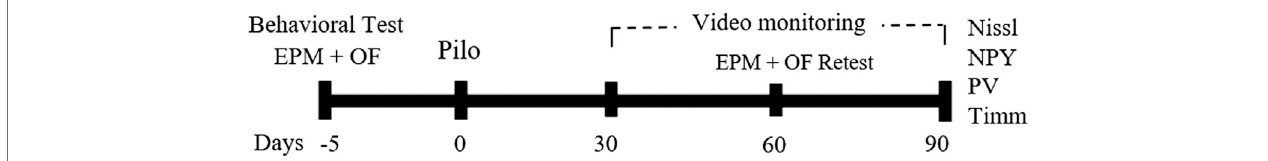
FIGURE1| Schematicrepresentation oftheexperimental timeline. Fivedays prior thepilocarpine-inducedSE(day0), animalsweresubjectedtothebehaviortest. Thirty days after the SE, animals were video monitored. Sixty days after SE induction, a behavior retest was performed (day 60), and ninety days after SE, animals were perfusedandtheirbrainsprocessedforNisslandneo-Timmstaining,andforimmunohistochemistryagainstNPYandPV.EPM,elevatedplusmaze;OF,open fi eld;NPY, neuropeptide Y; PV,